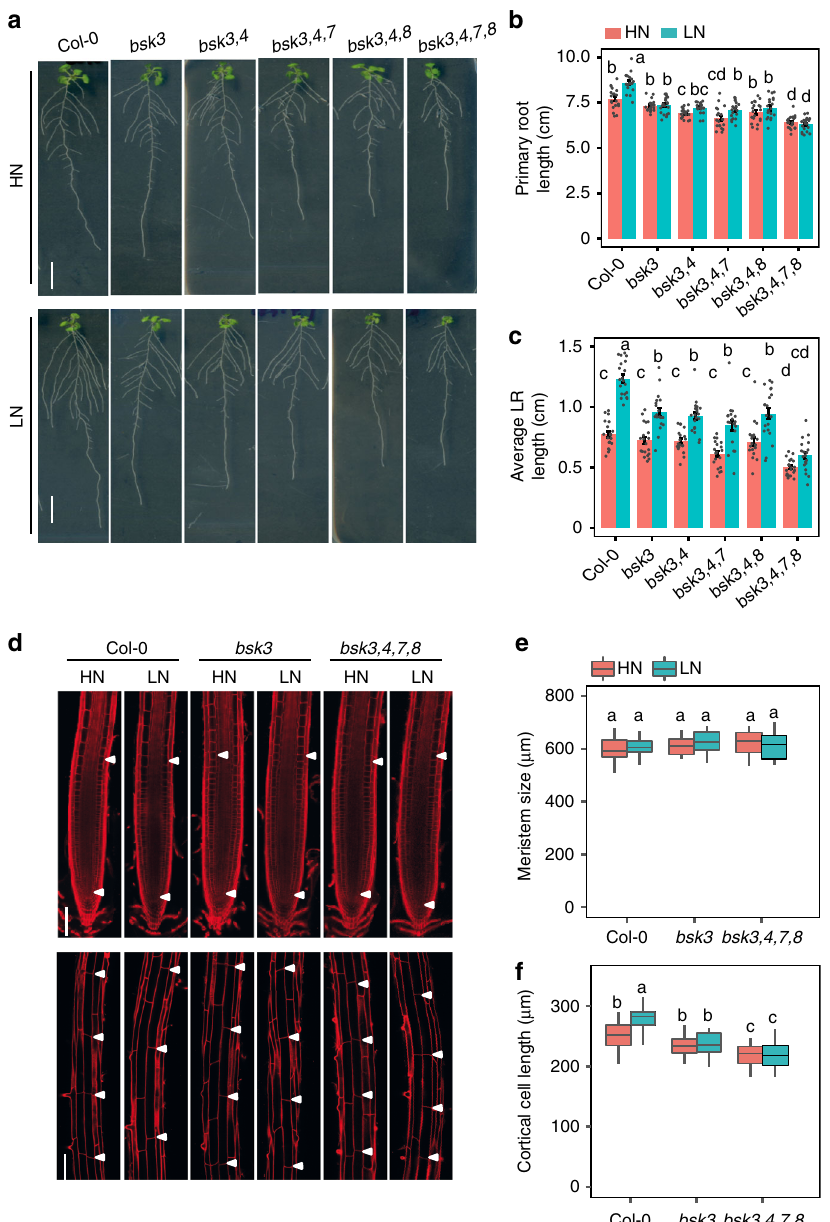
Fig. 2 Root architecture of bsk3 and multiple bsk knockouts under low N. a – c Appearance of plants ( a ), primary root length ( b ), and average lateral root length ( c ) of wild-type (Col-0) and single or multiple bsk mutant plants grown at HN or LN. Bars represent means± SEM ( n = 20 independent biological replicates). Scale bars, 1 cm. d Representative confocal images of root meristem (upper panel) and length of cortical cells (bottom panel) of wild-type (Col- 0), bsk3 , and bsk3 , 4 , 7 , 8 grown under HN or LN. In the upper panel, white arrowheads indicate the position of quiescent center (QC) and the boundary between the meristematic zone and elongation zone, whereas in the bottom panel they indicate the boundaries of two consecutive cortical cells. Scale bars, 100 μ m. e , f Length of meristem ( e ) and mature cortical cells ( f ) of wild-type (Col-0), bsk3 , and bsk3 , 4 , 7 , 8 grown under HN or LN ( n = 15 independent biological replicates). Root system architecture and cellular traits were assessed after 9 days. Horizontal lines show medians; box limits indicate the 25th and 75th percentiles; whiskers extend to 5th and 95th percentiles. Different letters indicate signi fi cant differences at P < 0.05 according to one-way ANOVA and post-hoc Tukey ’ s